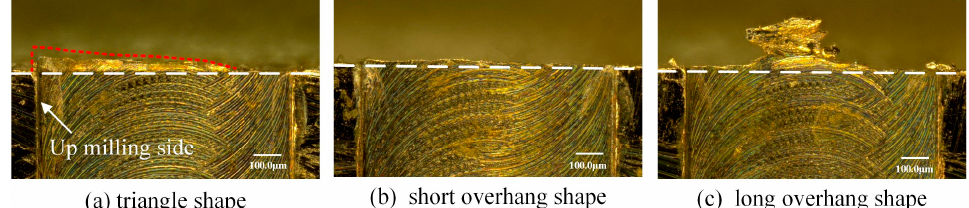
Figure 8. The exit burr shape classification. ( a ) Triangle shape. ( b ) Short overhang shape. ( c ) Long overhang shape.